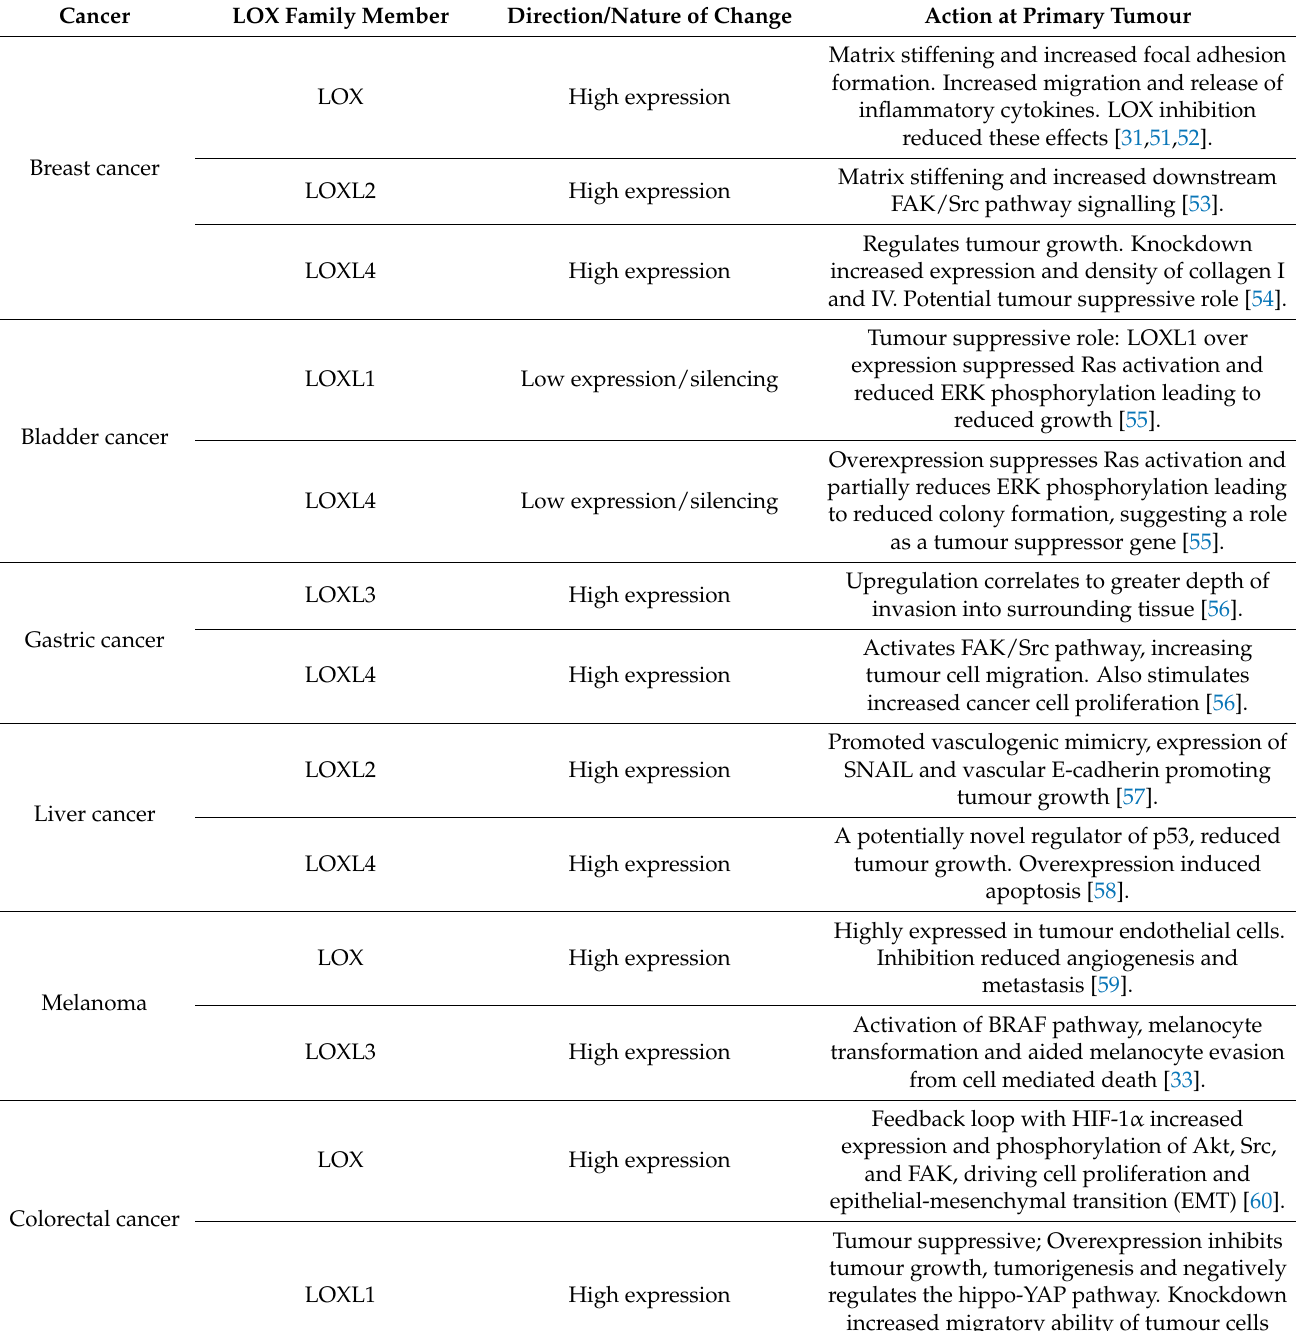
Table 1. Reported LOX family member involvement at the primary tumour